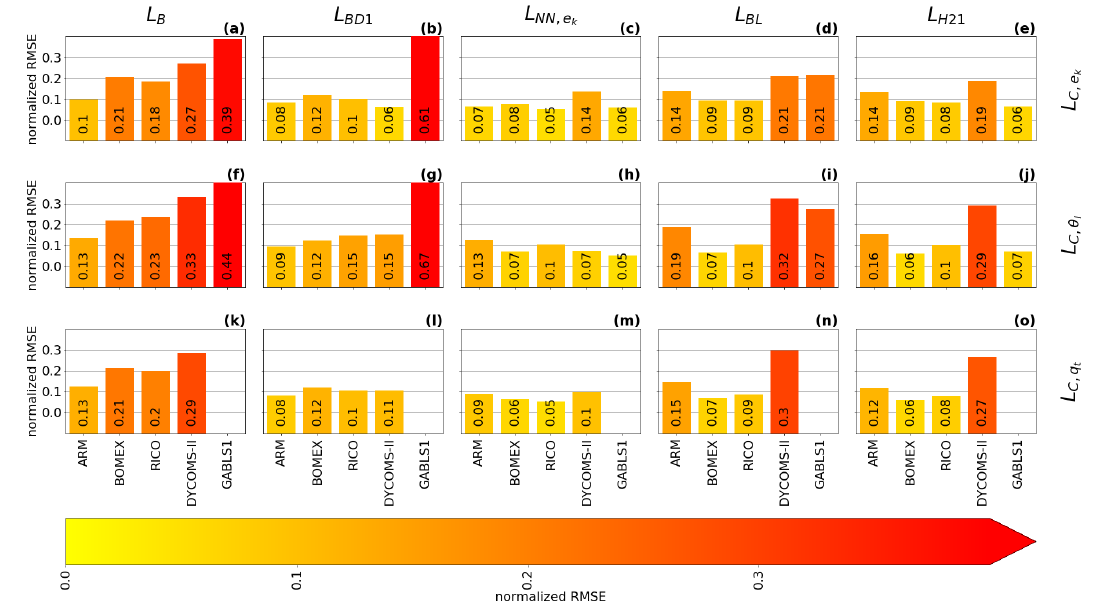
Figure 11. The time-averaged normalized RMSE (see Equation (38)) of the turbulence length scale formulations: L B , L BD 1 , L NN , e , L NN , q , L BL , and L H 21 (columns); with respect to the three diagnostics t k (rows; L C , e : ( a – e ), L C , q : ( f – j ), L C , θ : ( k – o )). The normalized RMSE is calculated for the second-largest t k l sub-domain size ( N sd = 2 2 ).